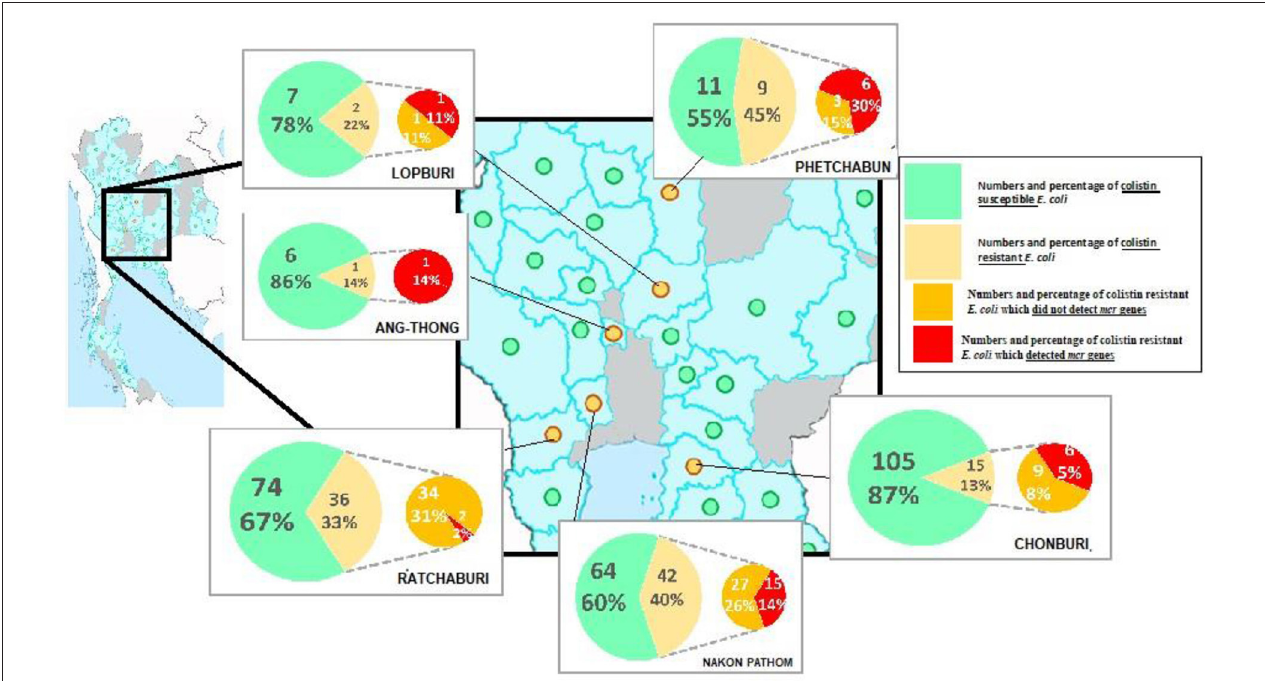
FIGURE 1 | Geographical distribution of either colistin resistant or susceptible E. coli from the surveyed contracted pig farms in Thailand.